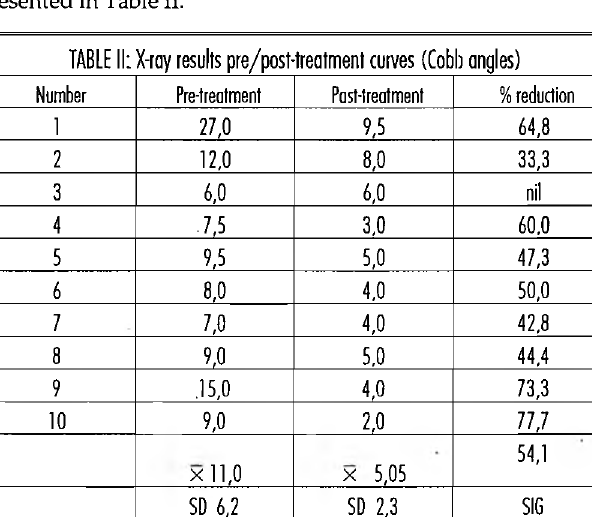
TABLE 1: Effects of programme on acromioal angle asymmetry Condition Subject number Angle of asymmetiy Pre-treatment acromial TABLE II: X-ray results pre/post-treatmenl curves (Cob )